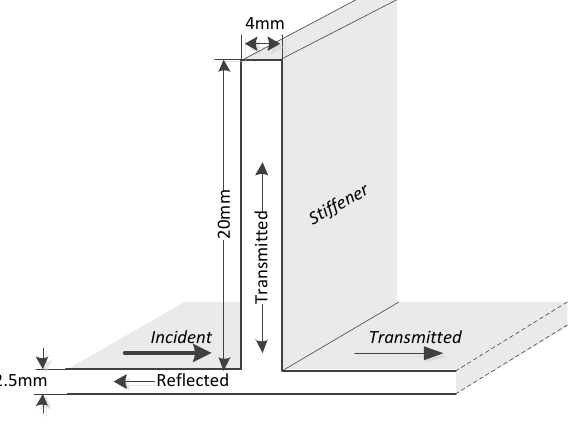
Figure 3. The model of ultrasonic propagation in an integral